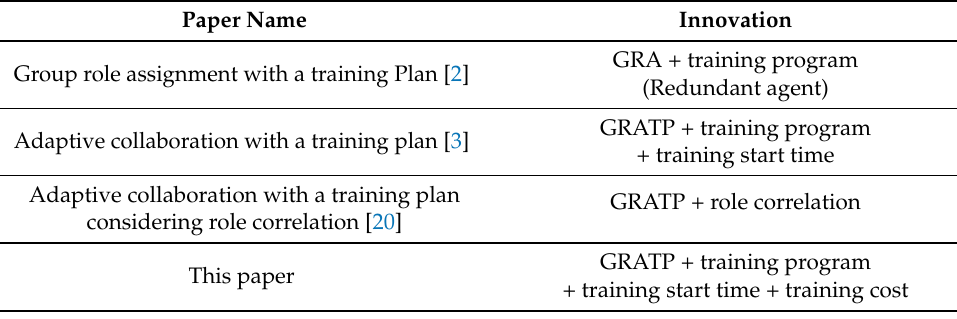
Table 1. The development of the